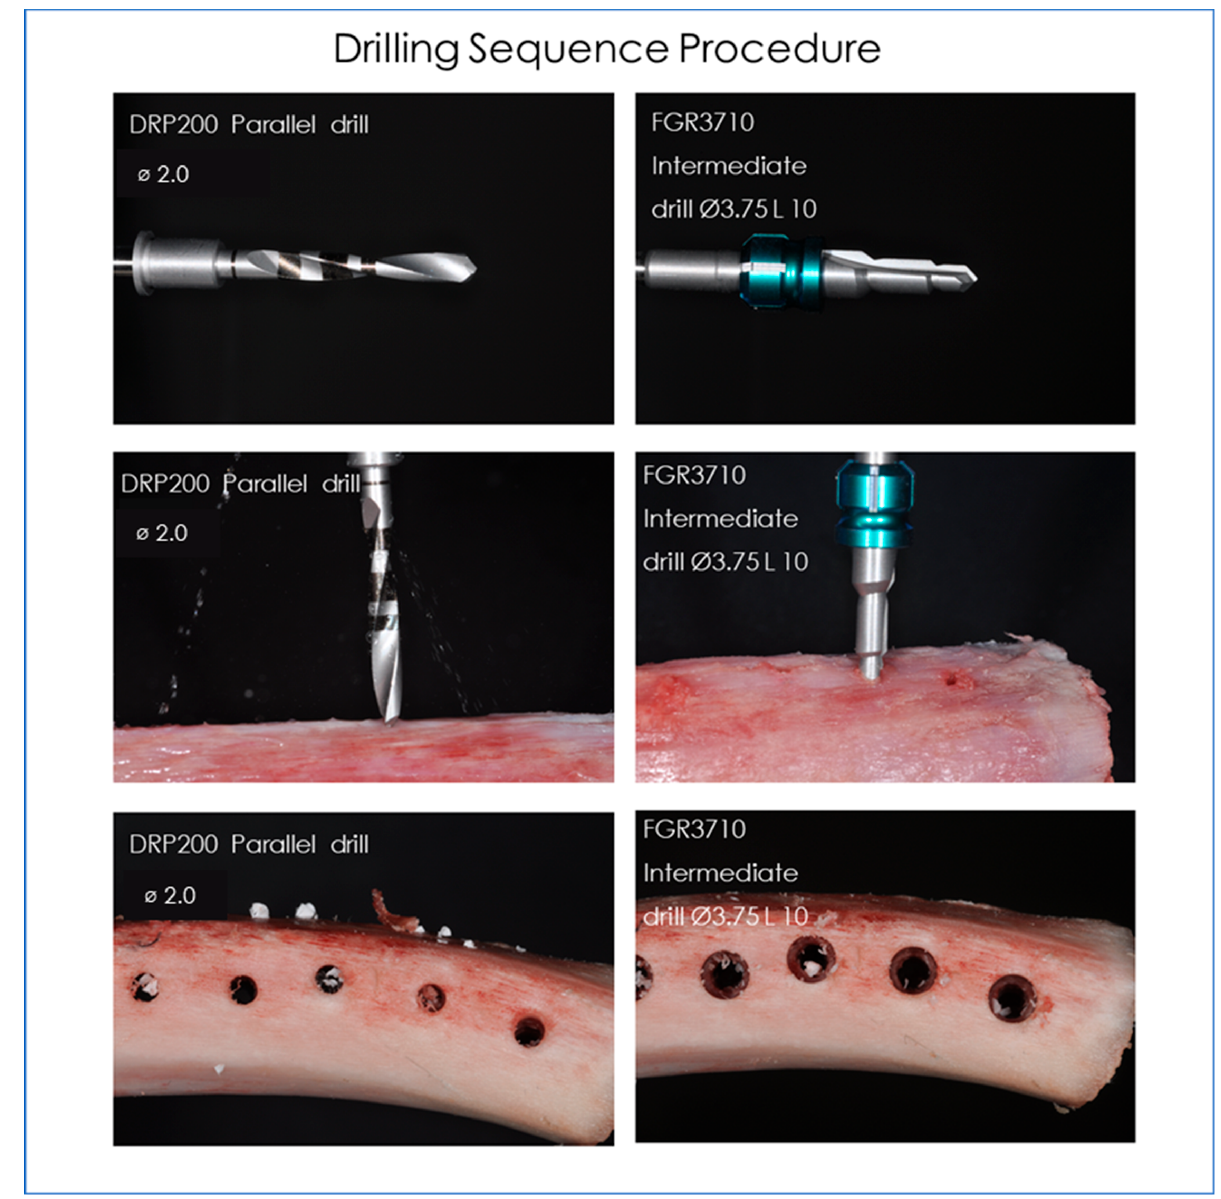
Figure 1. Details of the drilling sequence .